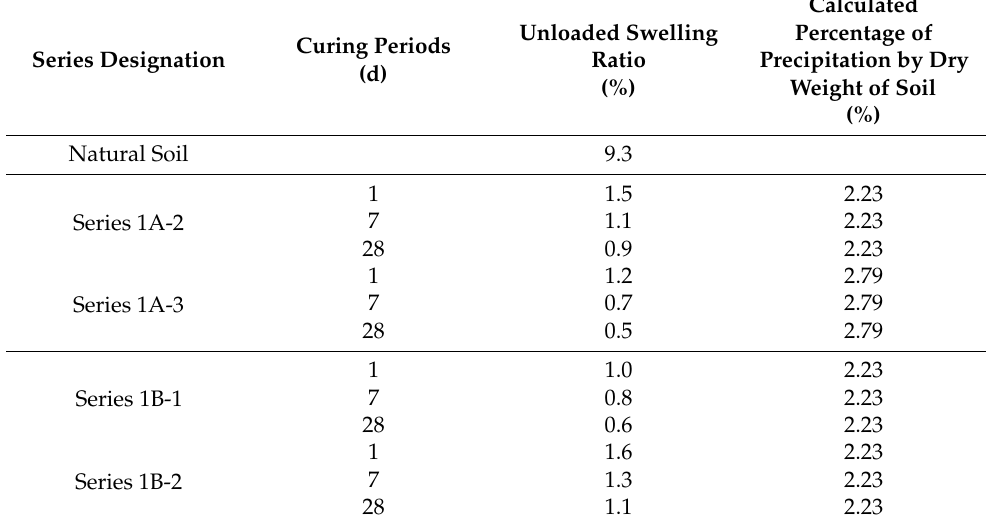
Table 6. The results of the unloaded swelling ratio tests.